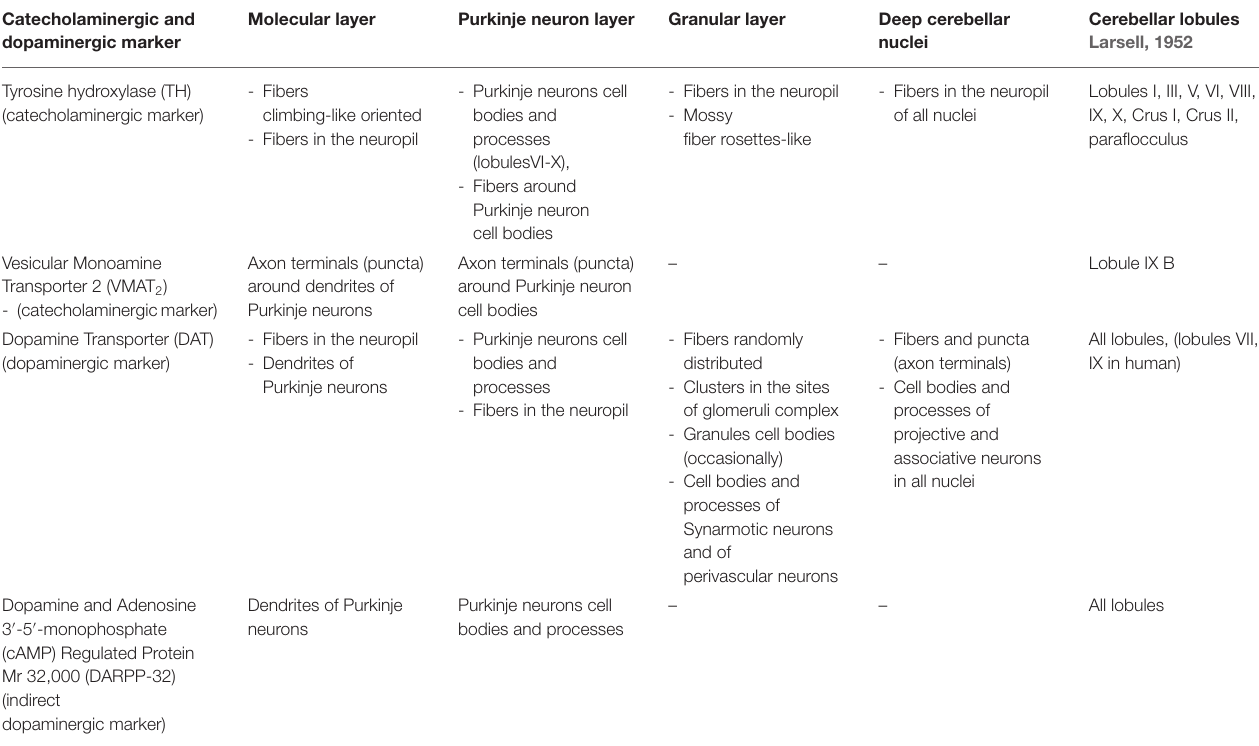
TABLE 1 | Distribution of the catecholaminergic and dopaminergic markers in the mammalian